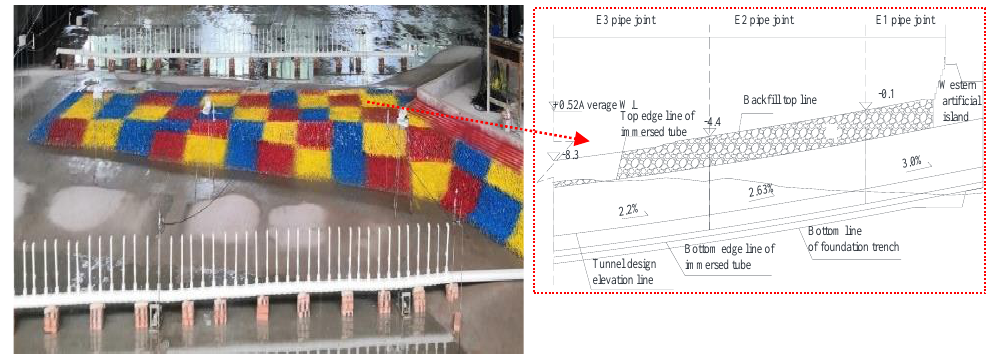
Figure 3. Completion of model making.